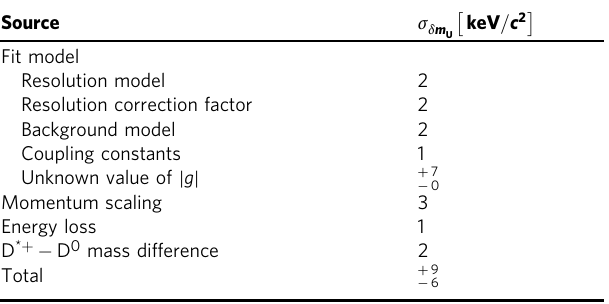
Table 3 Systematic uncertainties for the δ m U